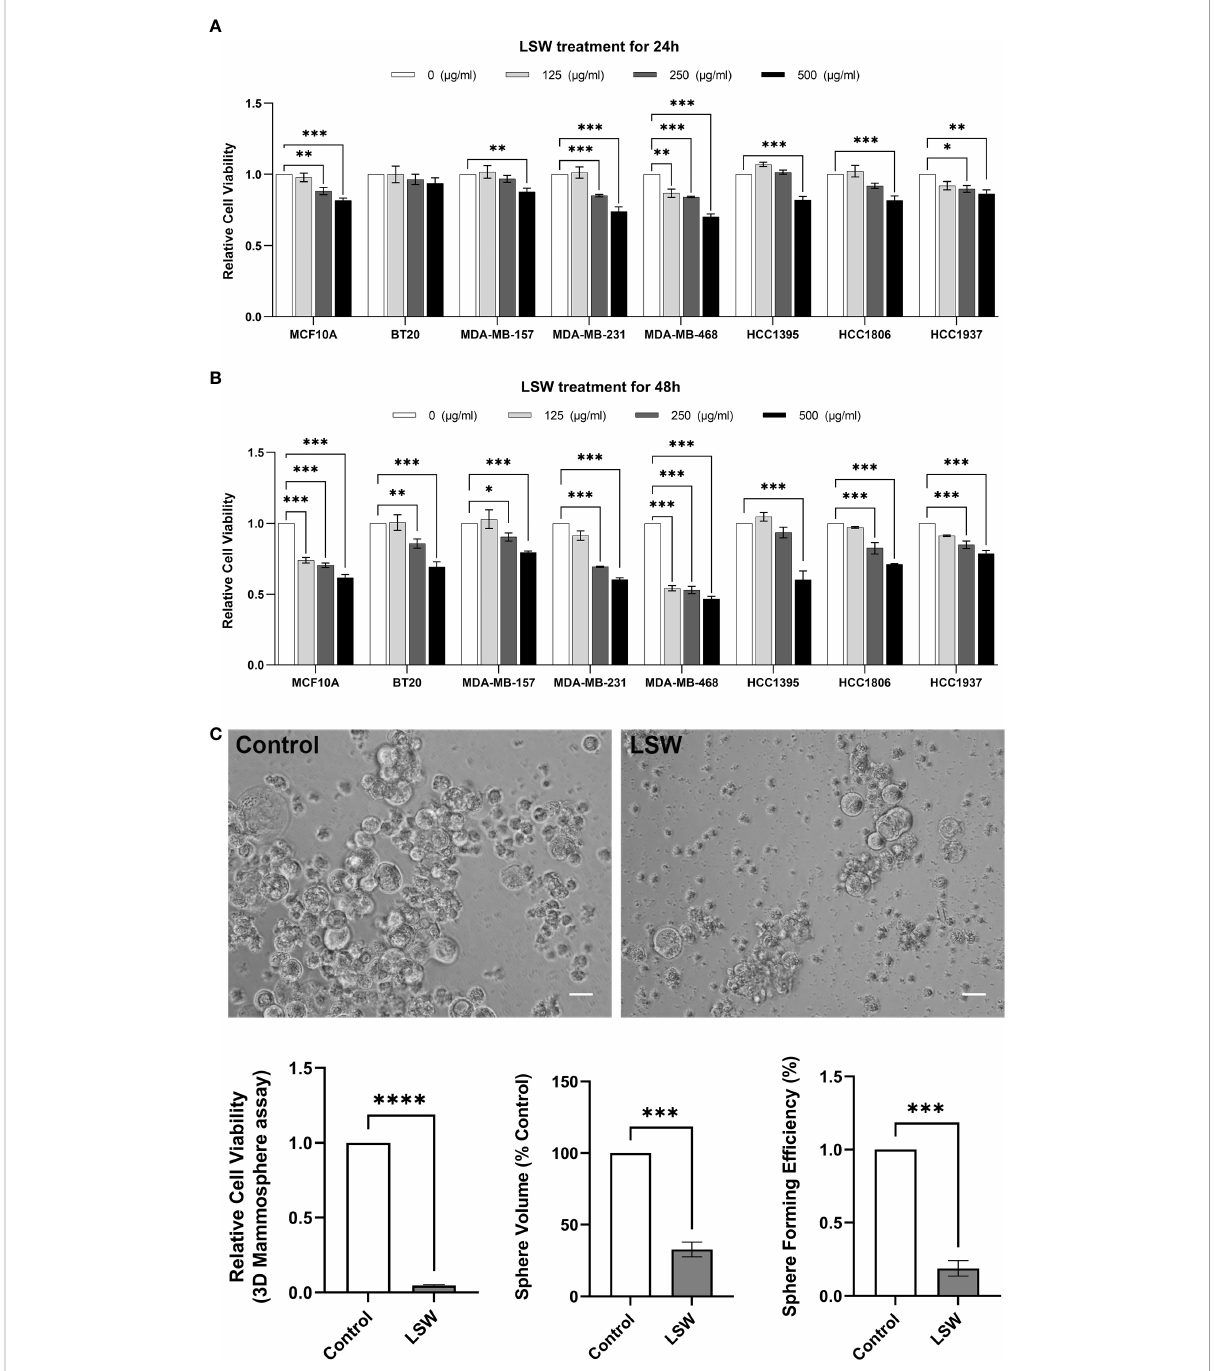
FIGURE 1 Effects of bioactive extracts from Limonium Sinense on cell viability. (A, B) Graphs showing relative cell viability in multiple cell lines treated with Limonium Sinense water extracts (LSW) at the indicated concentration for 24 (A) or 48 hours (B) in 2D cultures. Cell-Titer Glo ® assay was performed to measure cell viability. Data are mean ± SEM; n = 3 samples per group. ns, not signi fi cant; * P < 0.05; ** P < 0.01 and *** P < 0.001 by the Two-way ANOVA. (C) Representative phase contrast microscopy images showing cell viability (Cell-Titer Glo ® assay), sphere volume, and sphere formation ef fi ciency in MDA-MB-468 cells with the indicated treatment cultured in 3D. Scale bar: 50µm. Data are mean±SEM. n=3 samples per group. *** P <0.001; **** P <0.0001 by the Student ’ s t